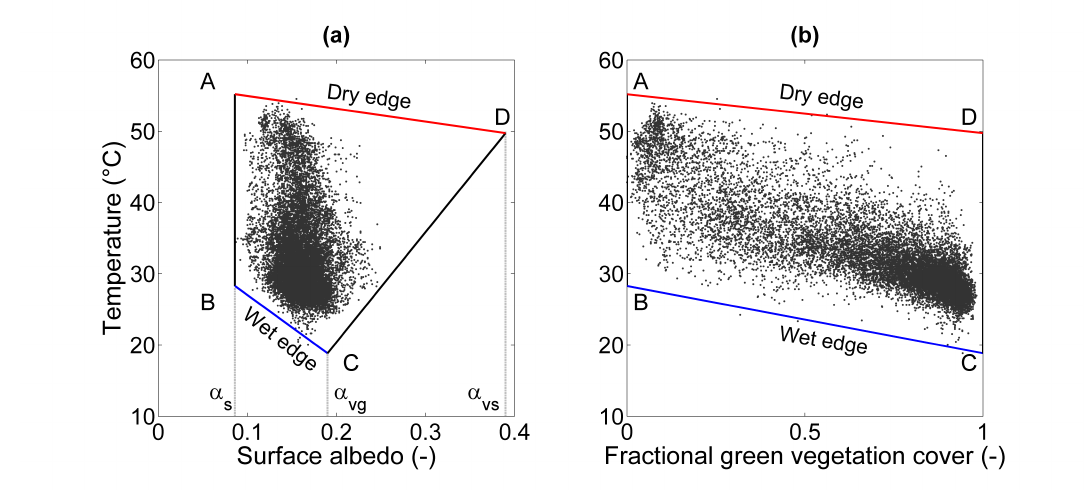
Figure 5. ( a ) Interpretation of the edges and vertices of the LST − α and ( b ) the LST − f polygons. Underlying points correspond to 90-m resolution data acquired on 11 April, over the Yaqui